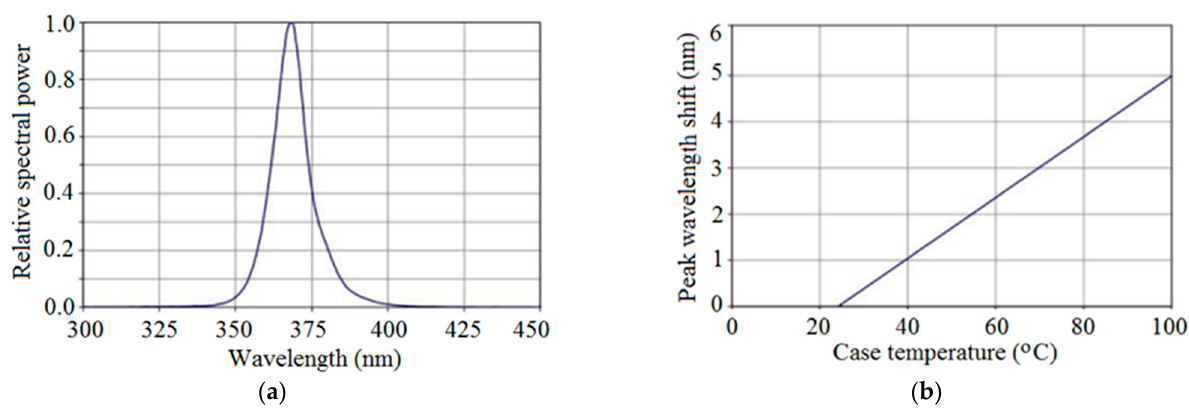
Figure 2. Characteristics of powerLED 1W-UV 365 nm diodes in the UV-WL365-P36 chamber radiator: ( a ) wavelength—relative spectral power, ( b ) case temperature—peak wavelength shift.